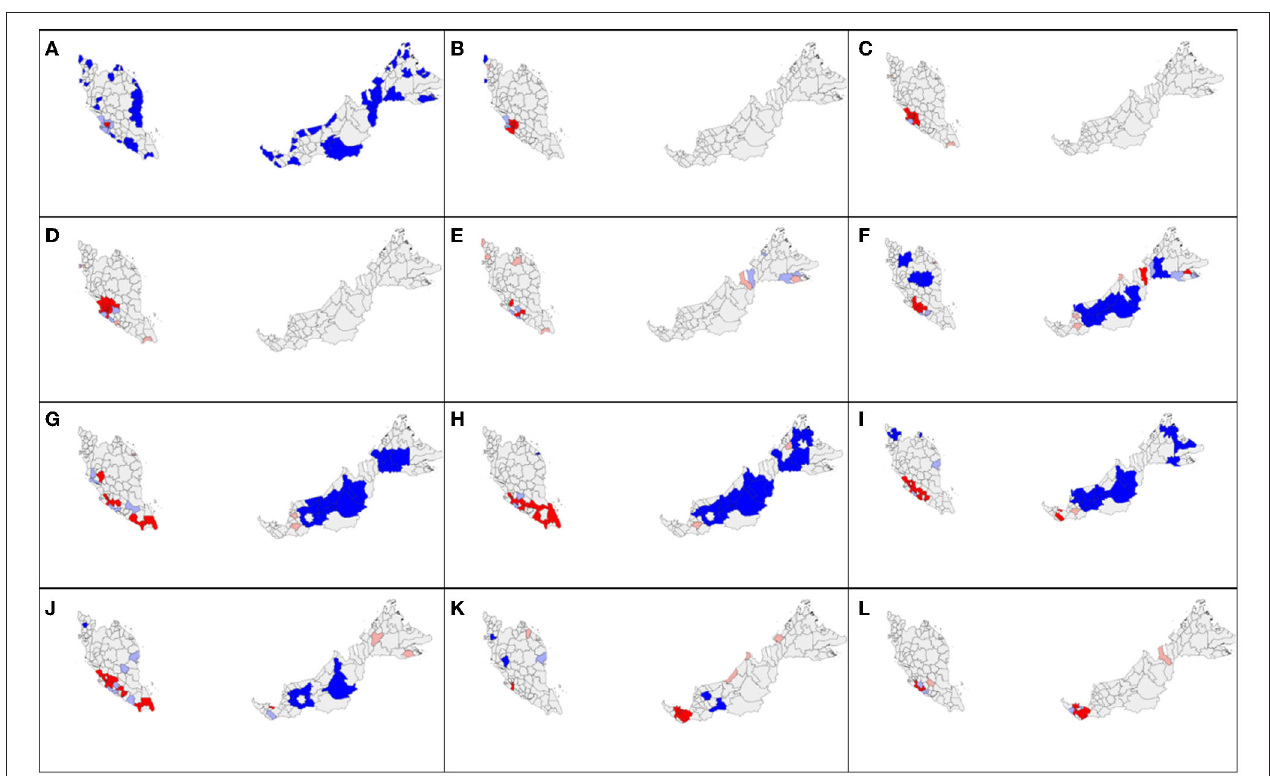
FIGURE 3 | Spatial autocorrelation distribution of COVID-19 new cases by district in Malaysia at cumulative sum of current and 7 days retrospectively in 2020 on (A) February 4; (B) March 3; (C) March 6; (D) March 11; (E) March 14; (F) March 17; (G) March 26; (H) March 30; (I) April 12; (J) April 15; (K) April 21; (L) April 30. Red color indicates high-high cluster, pink indicates high-low, blue indicates low-low, and light blue indicates low-high